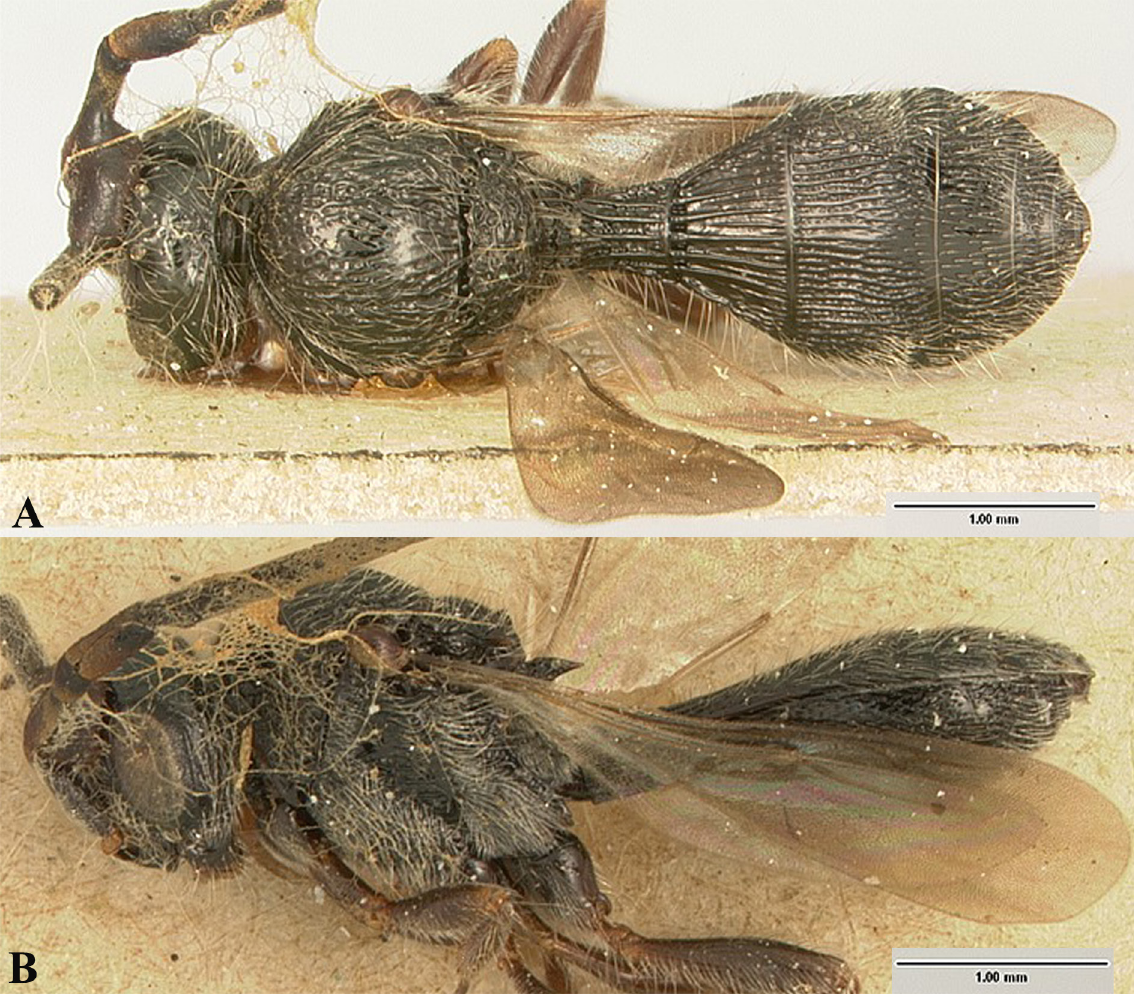
Fig. 17. Odontoscelio striatifrons Kieffer, 1905. Holotype, ♂ (MCSN). A . Habitus, dorsal view. B . Habitus, lateral view. Photos: N.F. Johnson © , Ohio State